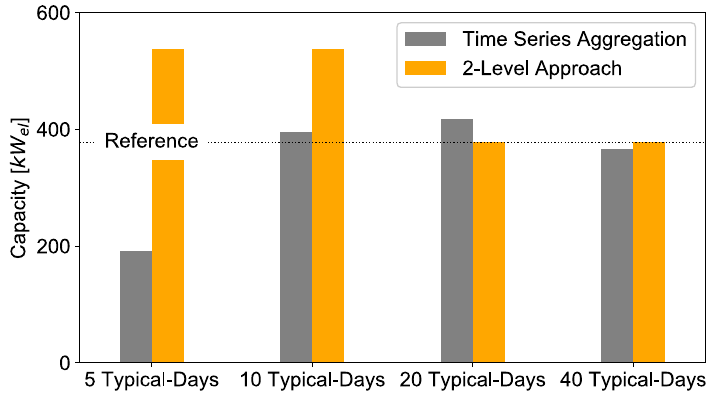
Figure 16. Deviation of installed backup plant capacities with the 2-Level Approach and time series aggregation compared to full time series.